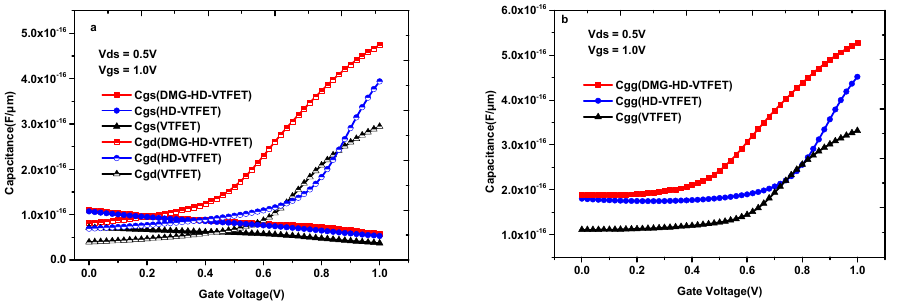
Figure 11. ( a ) Cgs and Cgd comparison diagram; and ( b ) Cgg comparison diagram of VTFET, HD-VTFET, and DMG-HD-VTFET.